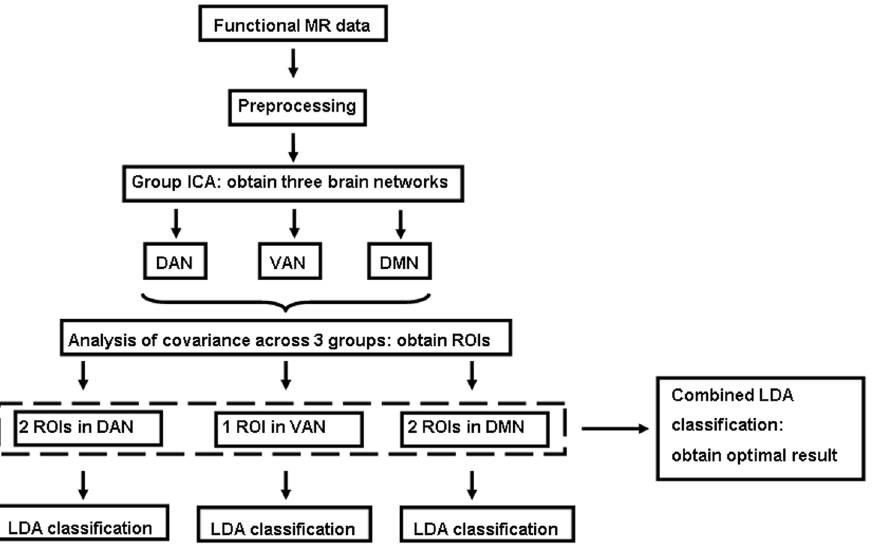
Figure 1. Summary of image processing and linear discriminant analysis. DAN, dorsal attention network; VAN, ventral attention network; DMN, default mode network; ROI, region of interest; LDA, linear discriminant analysis.